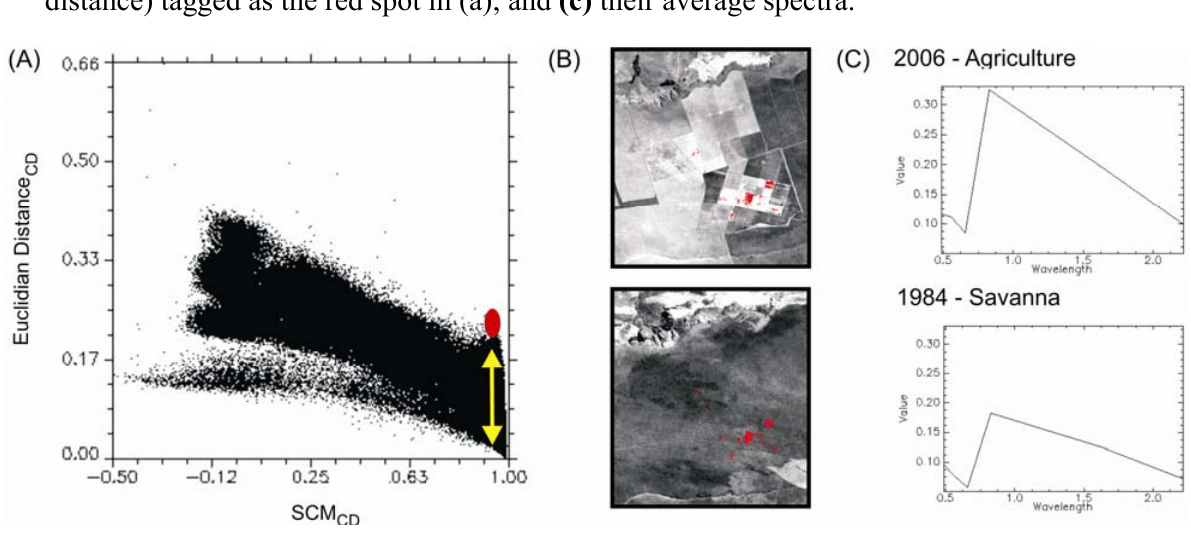
) versus Euclidian CD , Euclidian CD